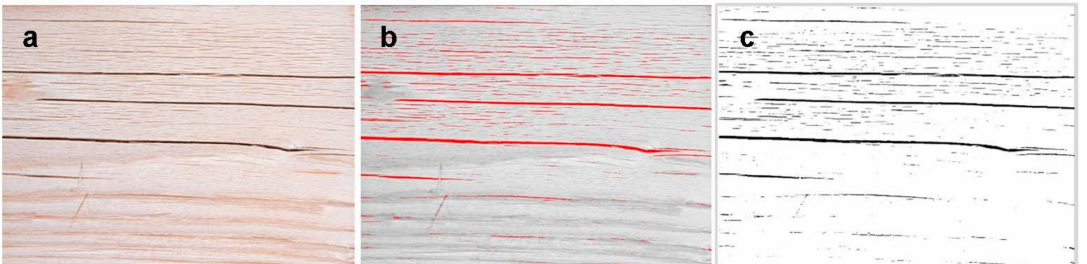
Figure 9. Example of image analysis using software ImageJ; captured 24-bit color depth image ( a ); 8-bit grayscale image with thresholding to identify the cracks ( b ); identified cracks for calculation ( c